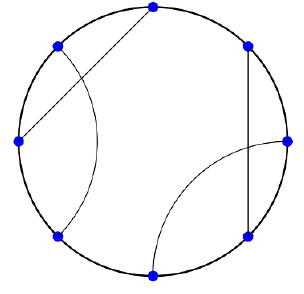
Figure 1 . A sample Chord